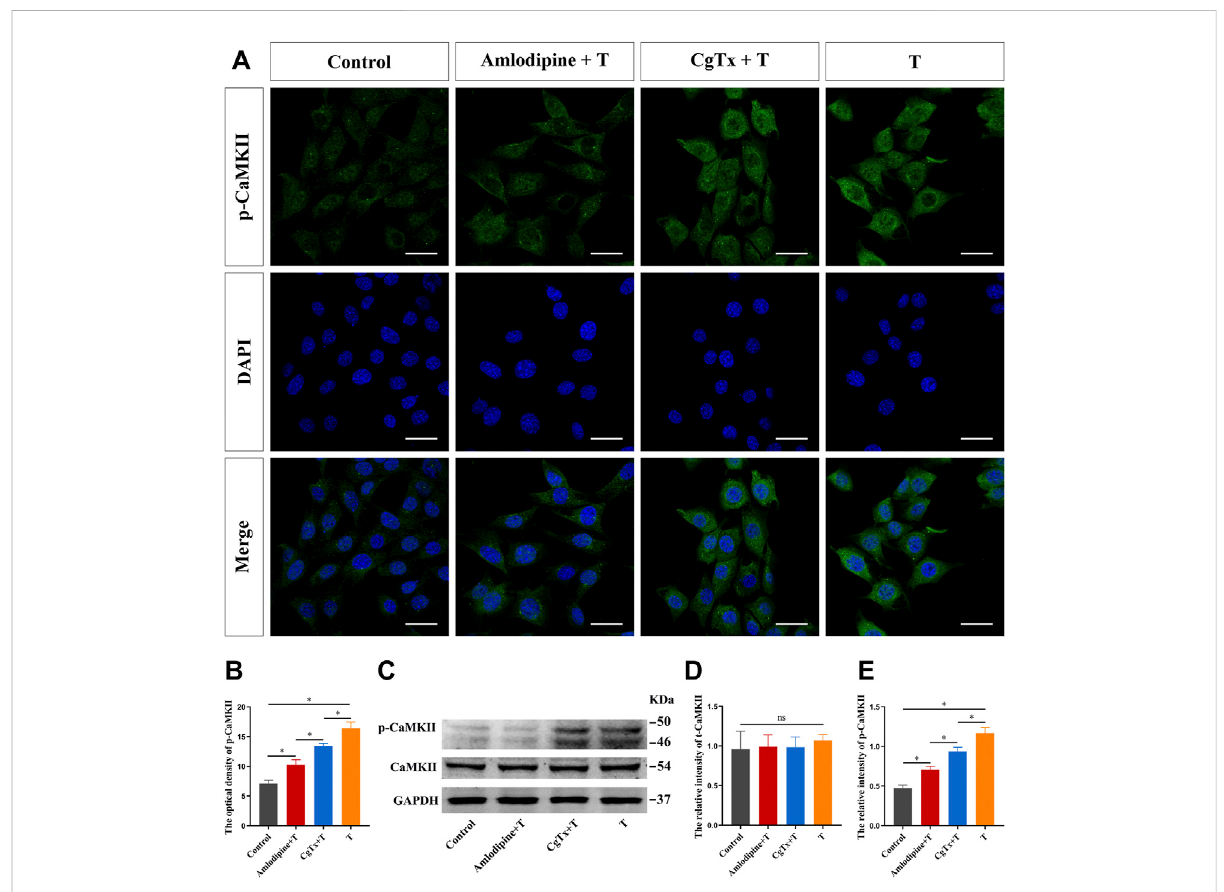
FIGURE 8 Voltage-gatedcalciumchannelsareinvolvedinT-inducedincreaseofCaMKIIproteininHT22cells. (A) Immuno fl uorescencecytochemistryfor p-CaMKII expression in HT22 cells pre-treated with T, amlodipine, or CgTx. (B) Statistical analysis of immuno fl uorescence cytochemistry for p-CaMKII expression in HT22 cells pre-treated with T, amlodipine, or CgTx. Scale bars = 20 μ m. (C) Western blotting for CaMKII and p-CaMKII proteinexpressioninHT22cellspre-treatedwithT,amlodipine,orCgTx. (D,E) StatisticalgraphofwesternblotanalysisofCaMKIIandp-CaMKII protein expression in HT22 cells pre-treated with T, amlodipine, or CgTx (* p <